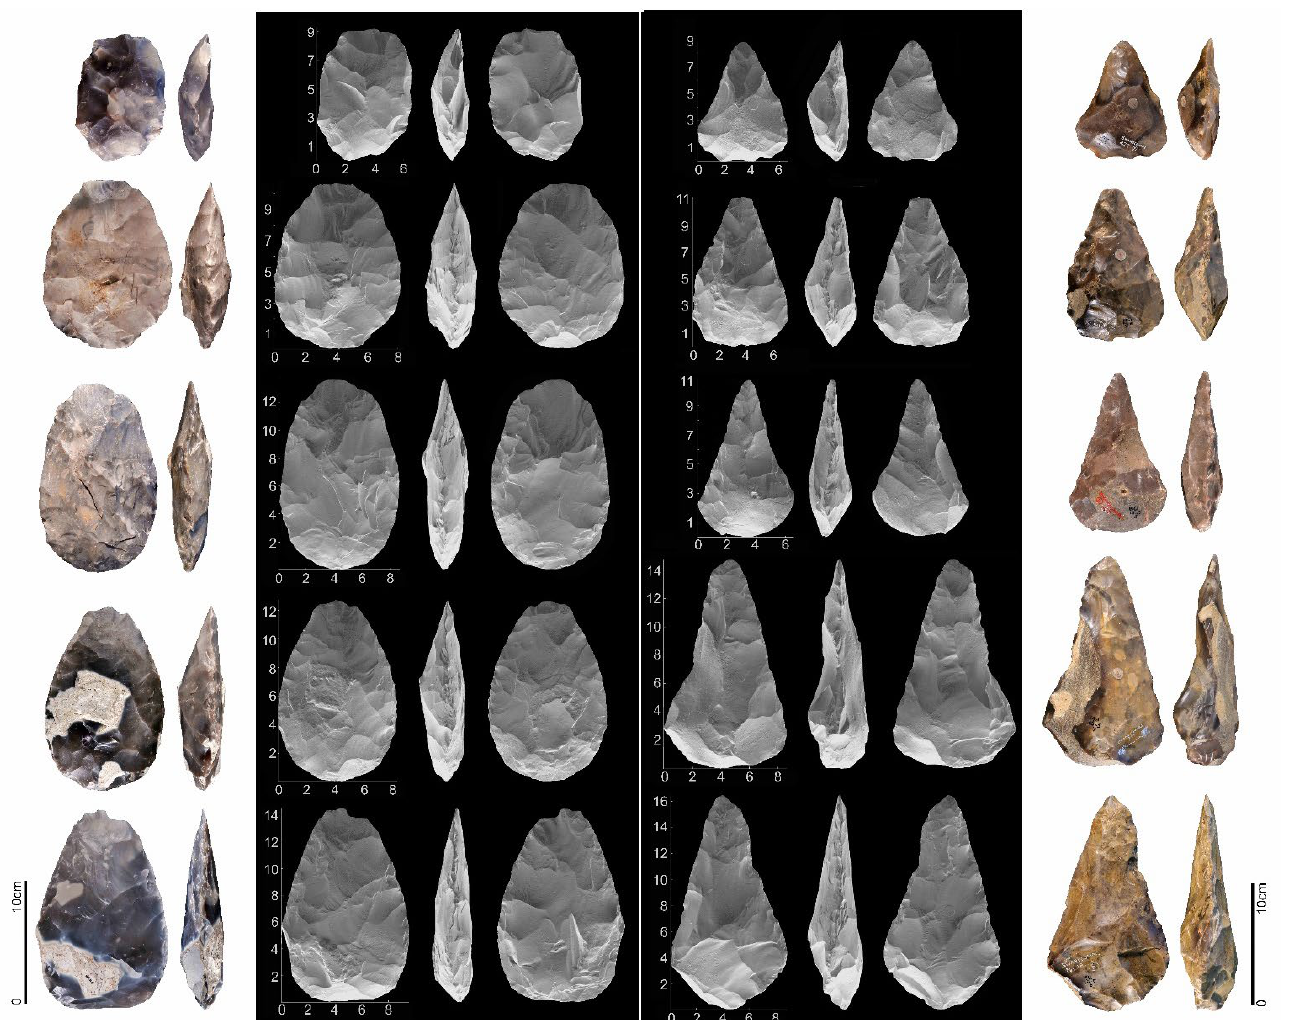
Figure 2. Examples of handaxes from Boxgrove Q1B Unit 4 (left) and Swanscombe-UMG (right) used with this methodological approach. The 3D images have been extracted using Artifact3-D Software (Grosman et al. ,